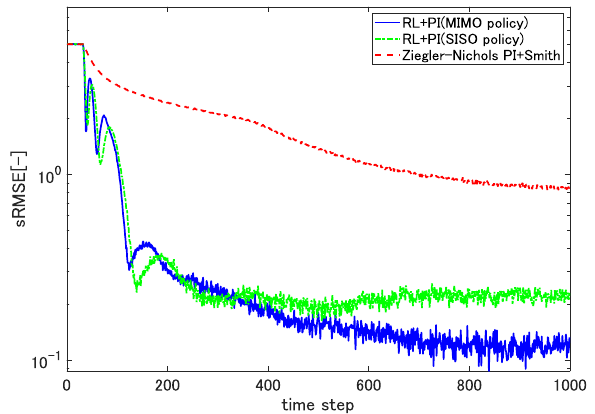
Figure 8. Transient changes in sRMSE metrics calculated with three different controllers.